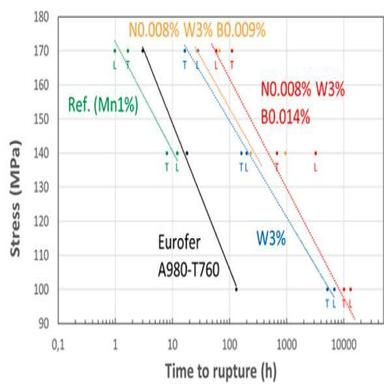
Creep tests performed at 650◦C on 9Cr RAFM steels with various W and B contents.